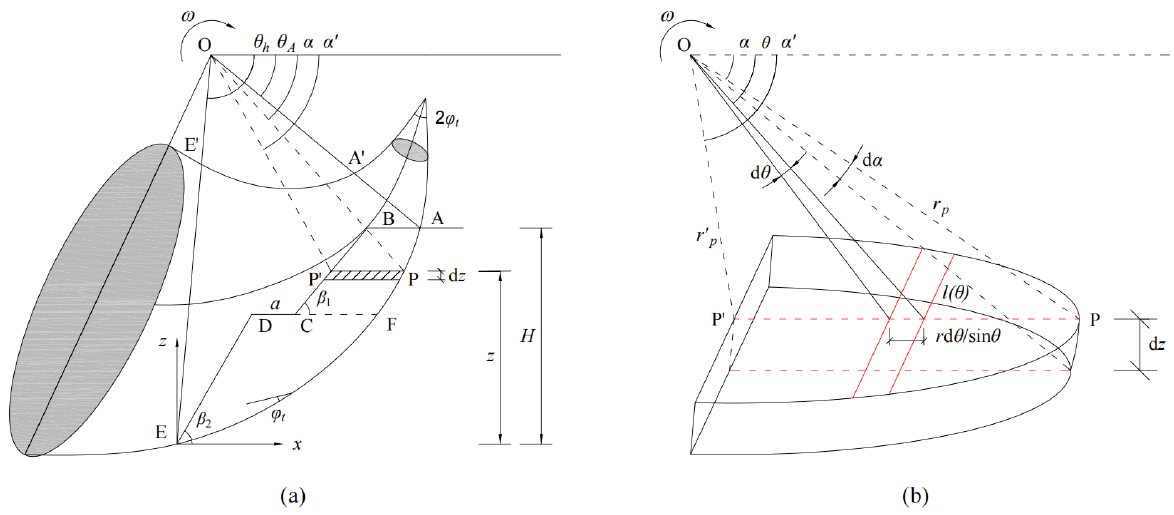
Figure 4. Schematic diagram of the layer-wise summation method: ( a ) entire graph; ( b ) the fine-tuned layer .